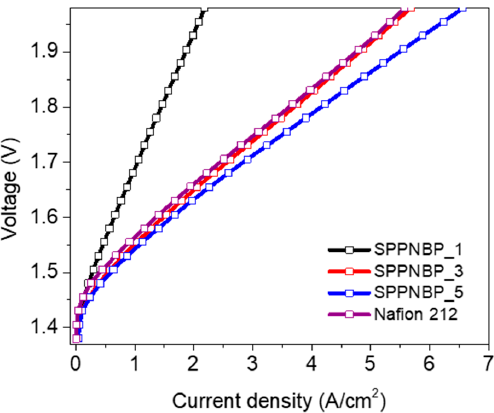
Figure 7. Polarization curves of SPPNBP_1, 3, and 5 membranes, and Nafion 212 membrane-based PEMWE single cells at 80 °C.